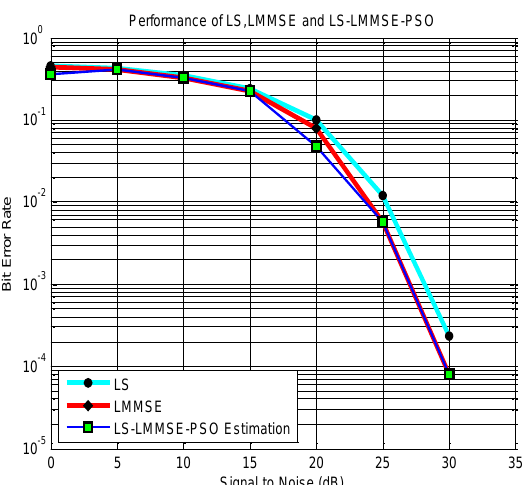
Figure 7: BER v/s SNR at Doppler frequency – 200 Hz